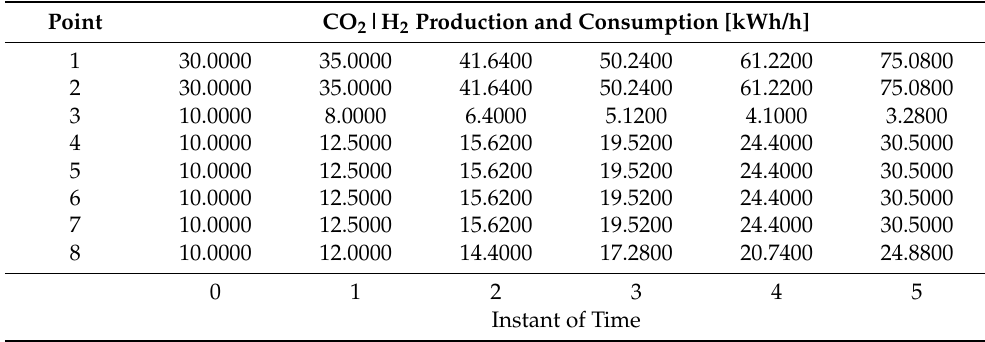
Table 2. CO 2 |H 2 production and consumption values for the pipeline network between the instants of time 0 and 5 with W F =